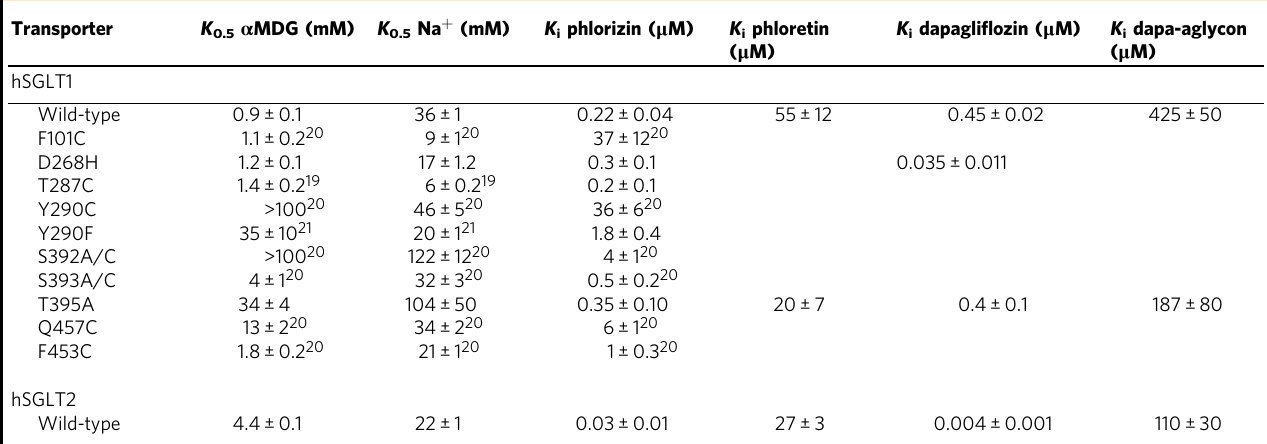
Table 1 Measured K i and K 0.5 values for hSGLT2, hSGLT1 and hSGLT1 mutants